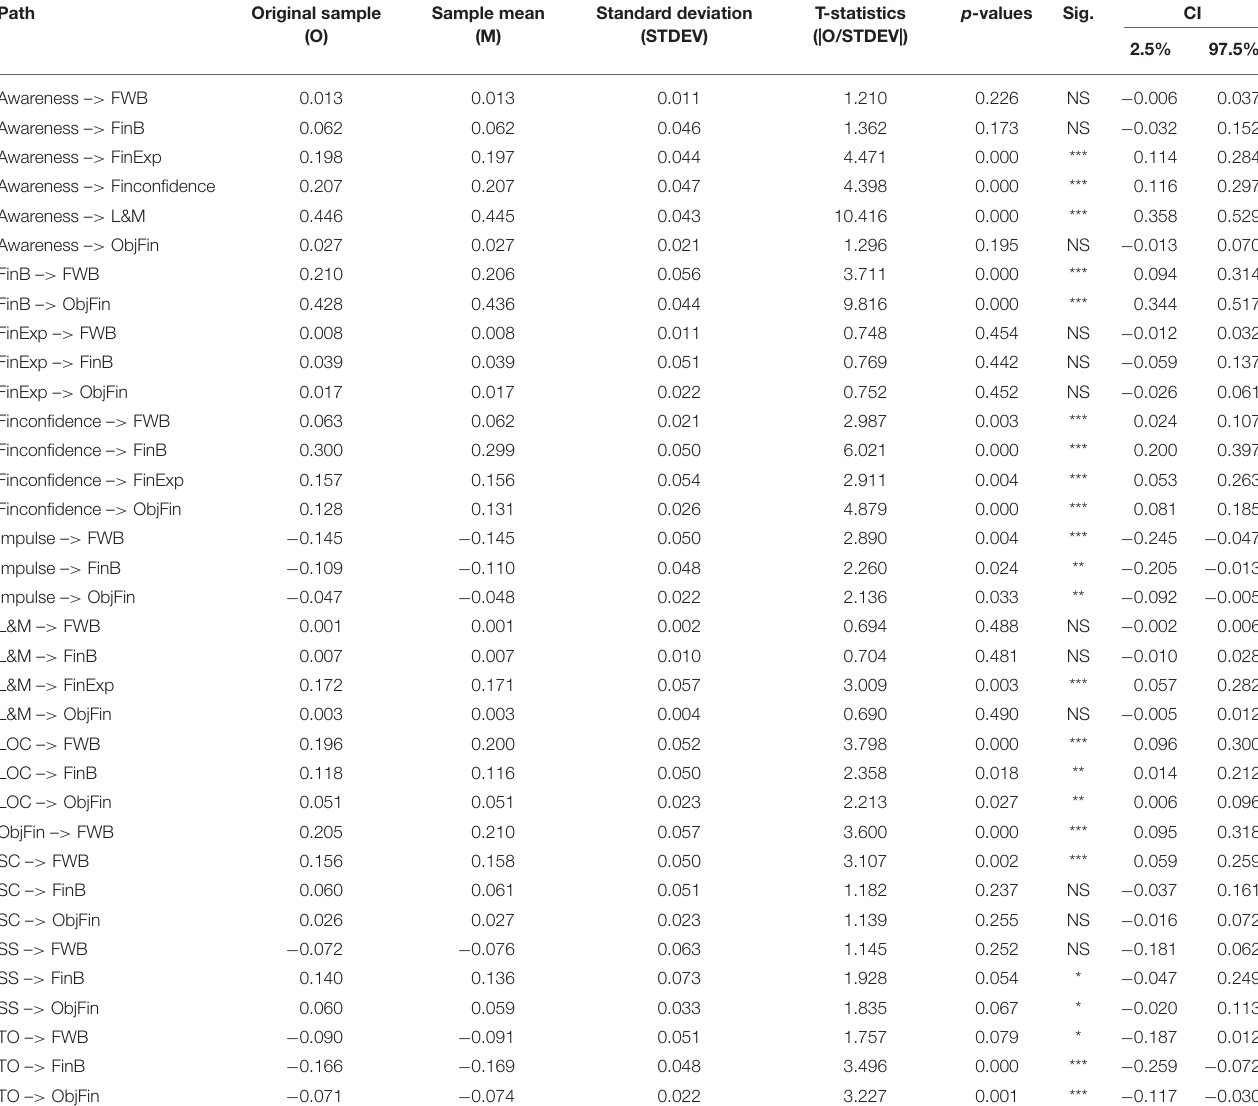
TABLE 8 | Significance of total